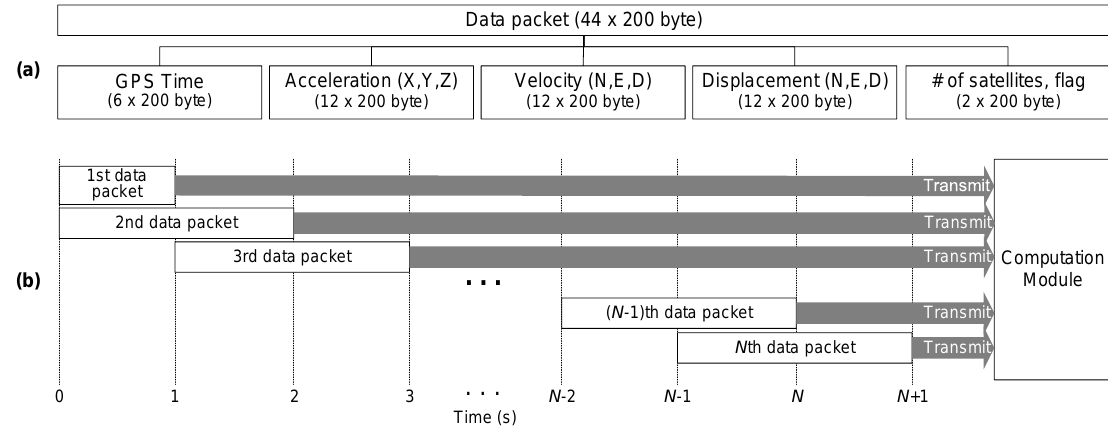
Figure 5. The data packet produced in the sensor module: ( a ) data packet structure; and ( b ) data packet transmission process.